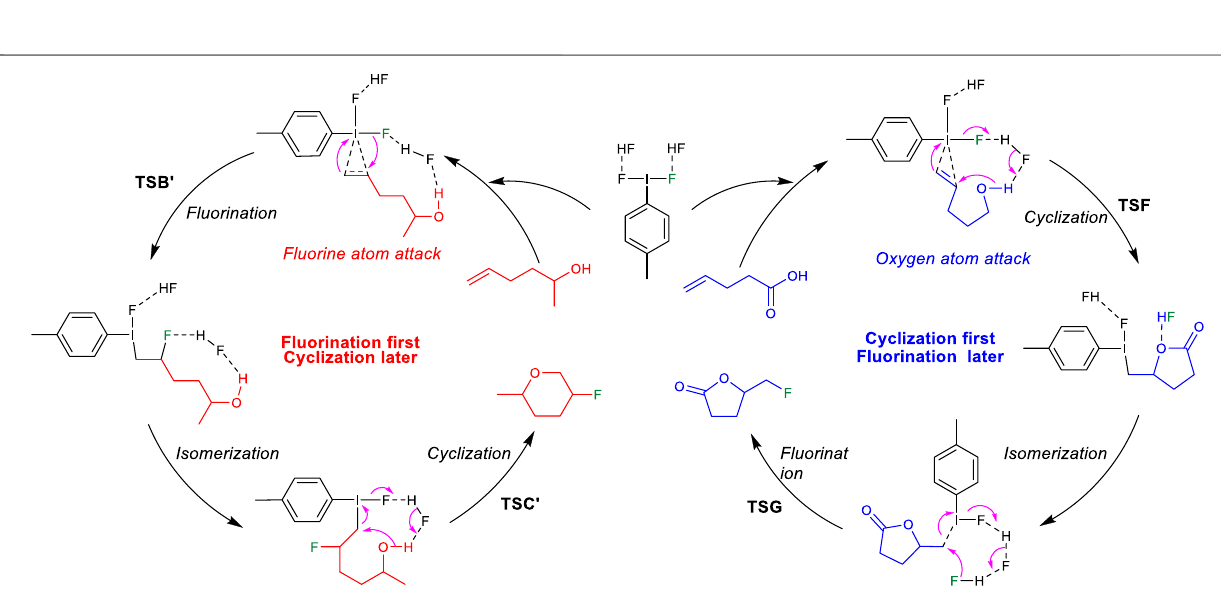
SCHEME 2 | Mechanism-dependent selectivity in di fl uoroiodotoluene-promoted fl uorocyclization of unsaturated alcohols and unsaturated carboxylic acids.